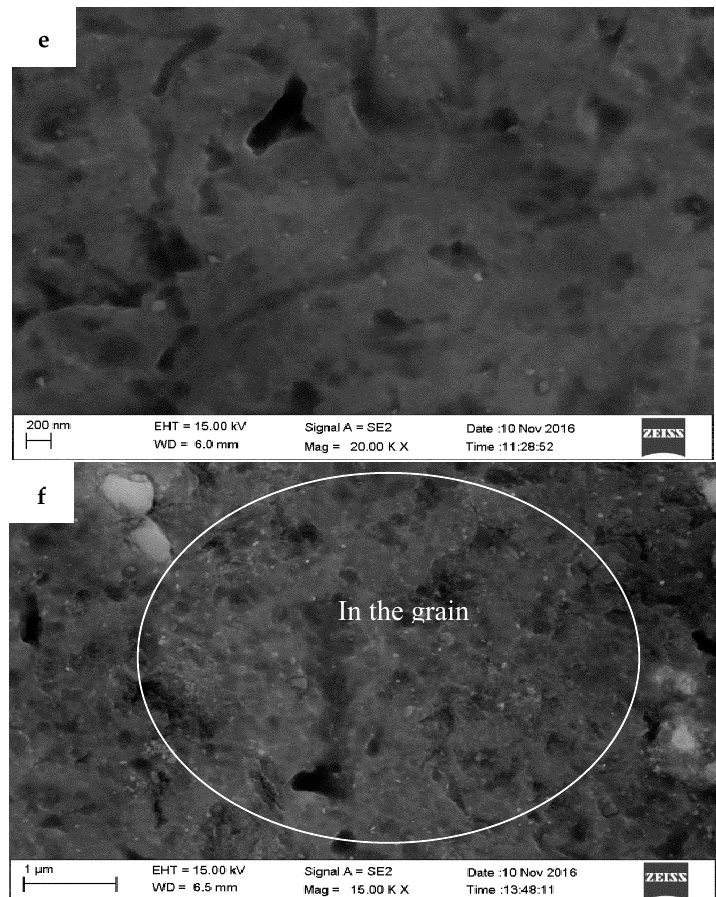
Figure 8. The distribution of TiB 2 particles ( a , b ) in the grain boundary of 4.5% TiB 2 /7075; ( c ) in the grain and grain boundary of 9.0% TiB 2 /7075; ( d ) in the grain near the grain boundary of 9.0% TiB 2 /7075; ( e ) in the grain of 4.5% TiB 2 /7075; and ( f ) 9.0% TiB 2 /7075 (white dot in the picture).